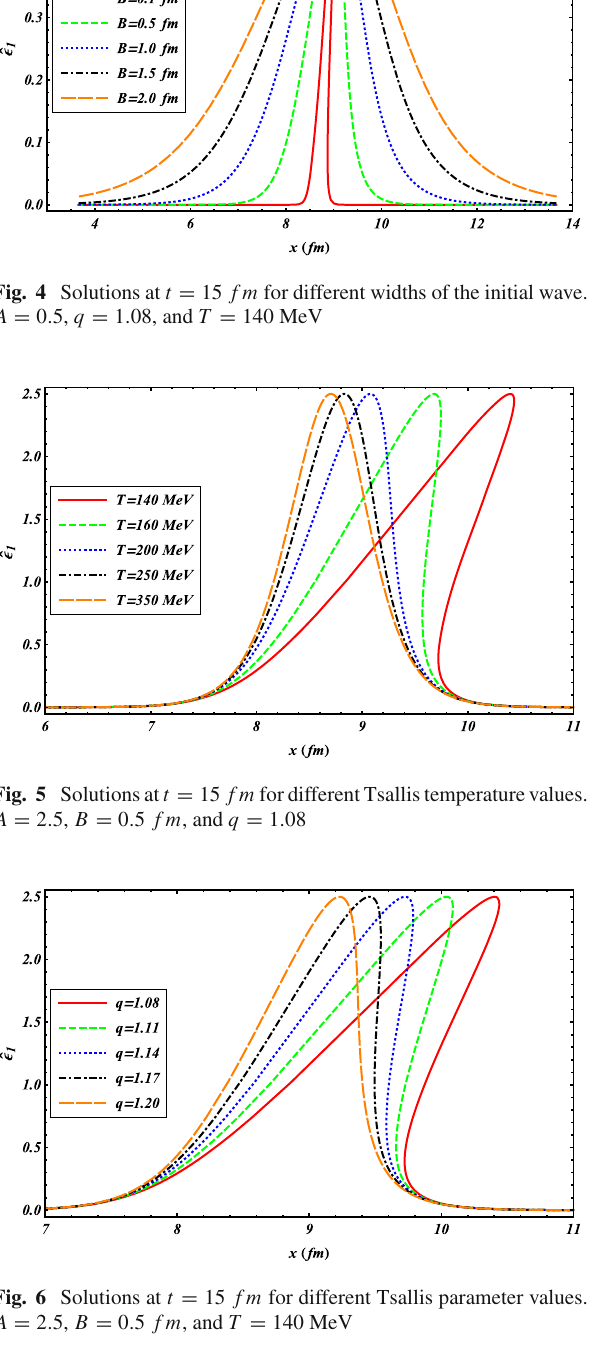
f m , A = 2 . 5, B = 0 . 5 f m , and q = 1 . 08). Similarly, a lower value of the q parameter indicates a higher likelihood of obtaining breaking waves (as seen in Fig. 6, where t = 15 f m , A = 2 . 5, B = 0 . 5 f m , and T = 140